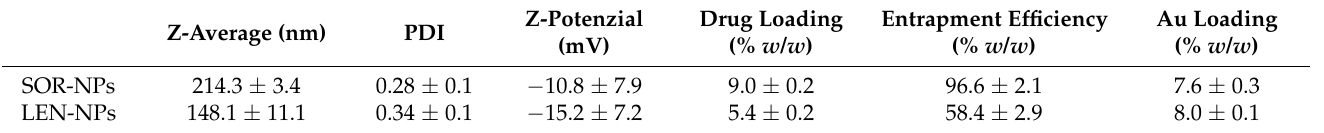
Table 2. Characterization of SOR-NPs and LEN-NPs: dynamic light scattering data, surface charge, drug, and gold content.